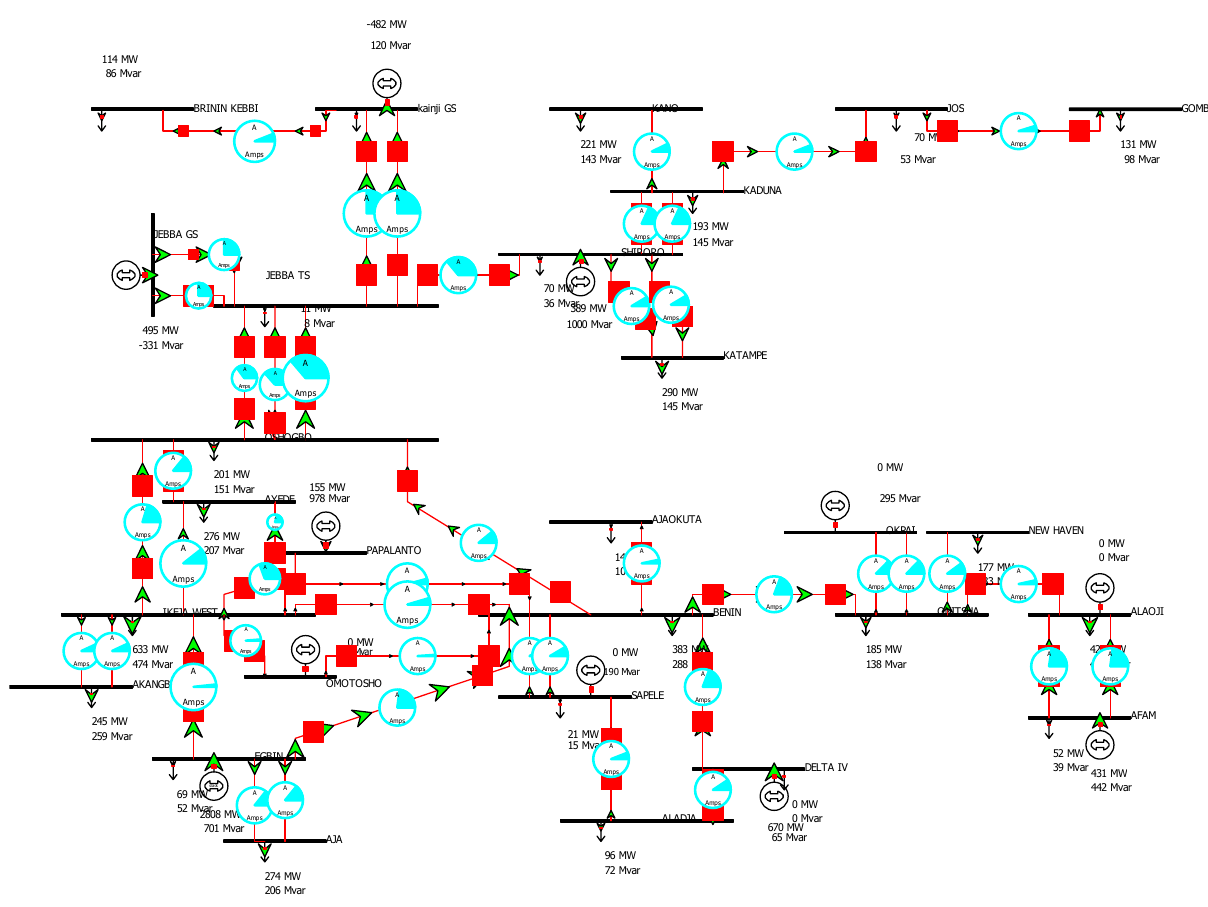
Fig. 5 Existing 330-kV transmission grid in the run mode of the